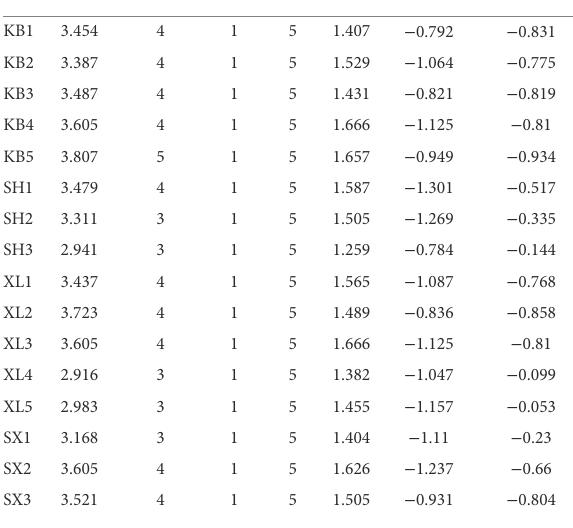
TABLE 5 Study 2: Descriptive statistical analysis of each variable (social environment).